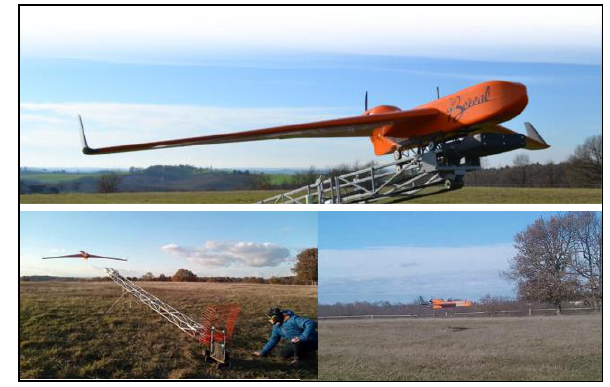
Figure 3. The BOREAL UAS on its catapult (top) and during take-off (bottom left) and landing (bottom